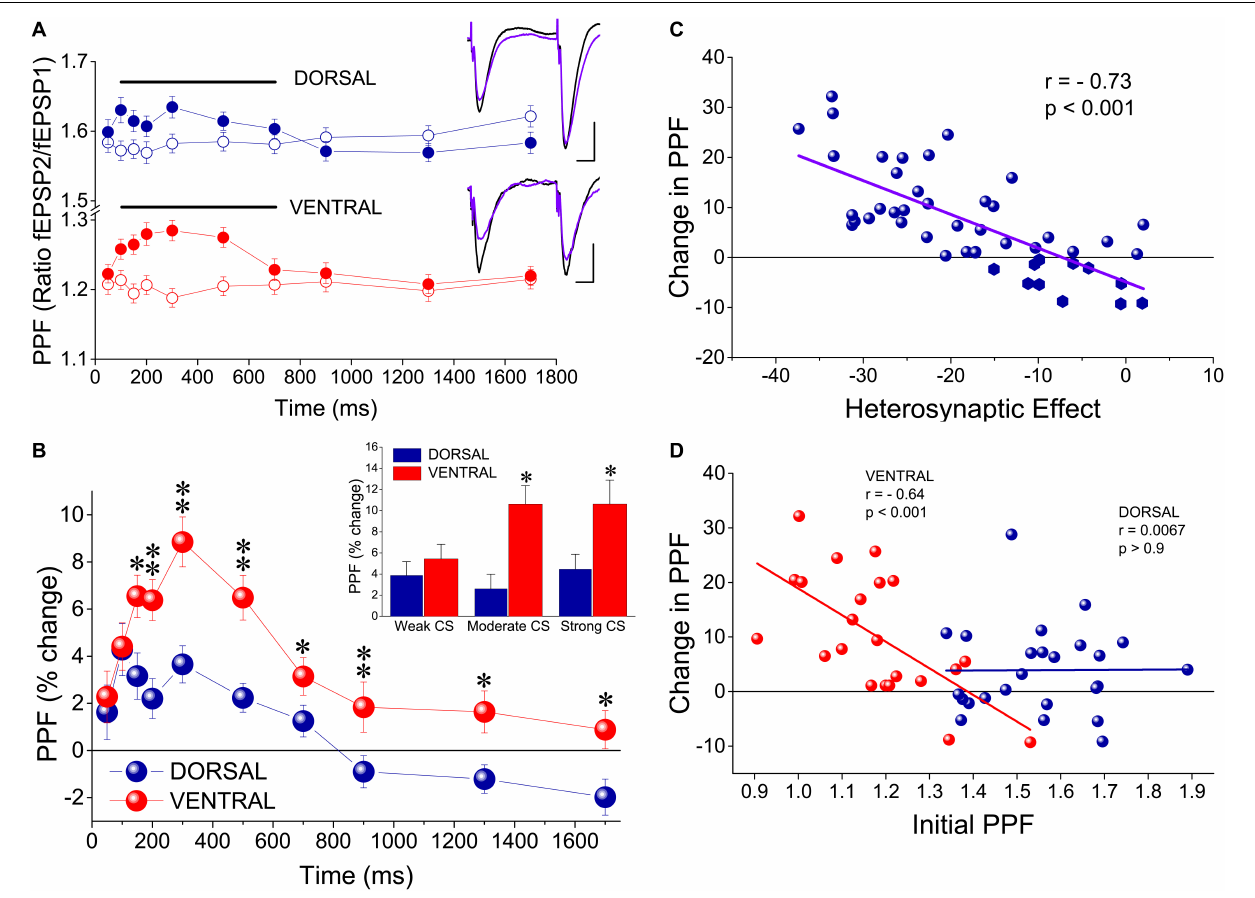
FIGURE 3 | tHSD is associated with a greater increase in paired-pulse facilitation (PPF) in the ventral compared with the dorsal hippocampus. (A) PPF before (open symbols) and during tHSD (filled symbols) in dorsal and ventral hippocampal slices. PPF is shown as the ratio between the second and the first fEPSP evoked by PPS of the test pathway at an IPI of 50 ms. Examples of recordings illustrating PPF at the test pathway before (traces in black) and after burst stimulation at the conditioning path are also shown. Calibration bars: 0.5 mV, 10 ms. Artifacts are truncated. Data were obtained from all three intensities of CS. Horizontal bars indicate statistically significant differences (paired t -test). The level of significance for the dorsal hippocampus is p < 0.05 (200 ms, 700 ms) and p < 0.005 (100 − 150 ms, 300 − 500 ms), and for the ventral hippocampus p < 0.001 (100 − 500 ms) and p < 0.01 (700 ms). (B) Comparison of PPF increase between the dorsal and the ventral hippocampus. Asterisks indicate statistically significant differences between the two hippocampal segments at * p < 0.05, ** p < 0.005. Data were obtained from all three intensities of CS. Insert: Comparison of PPF increase produced by heterosynaptic CS at 300 ms between the dorsal and the ventral hippocampus. Data are shown separately for the three intensities of CS. Asterisk denote statistically significant difference between the two hippocampal segments at p < 0.05. (C) Diagram of PPF changes induced by heterosynaptic CS plotted against corresponding scores of tHSD. Changes in PPF significantly correlated with the amount of tHSD (bivariate correlation analysis). (D) Diagram of change in PPF plotted against initial PPF. Data are shown separately for the dorsal and the ventral hippocampus. Changes in PPF inversely correlated with (relatively low) initial amount of PPF in the ventral but not the dorsal hippocampus (bivariate correlation analysis). Symbols represent mean value of individual slices calculated by pooling all three intensities of CS for an IPI of 300